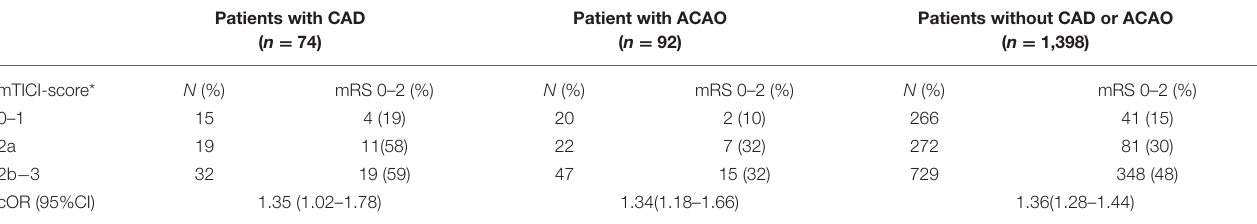
TABLE 4 | Proportions of functional independence stratified by reperfusion grades.